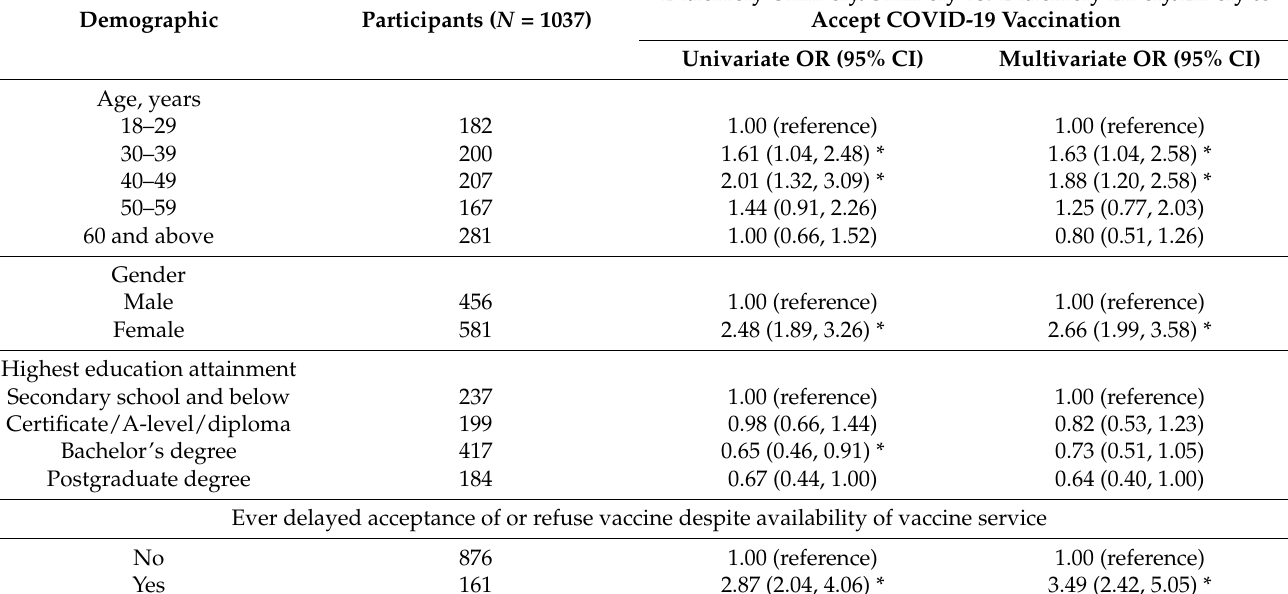
Table 3. Demographic characteristics influencing COVID-19 vaccination acceptance of the partici- pants in Japan ( N =